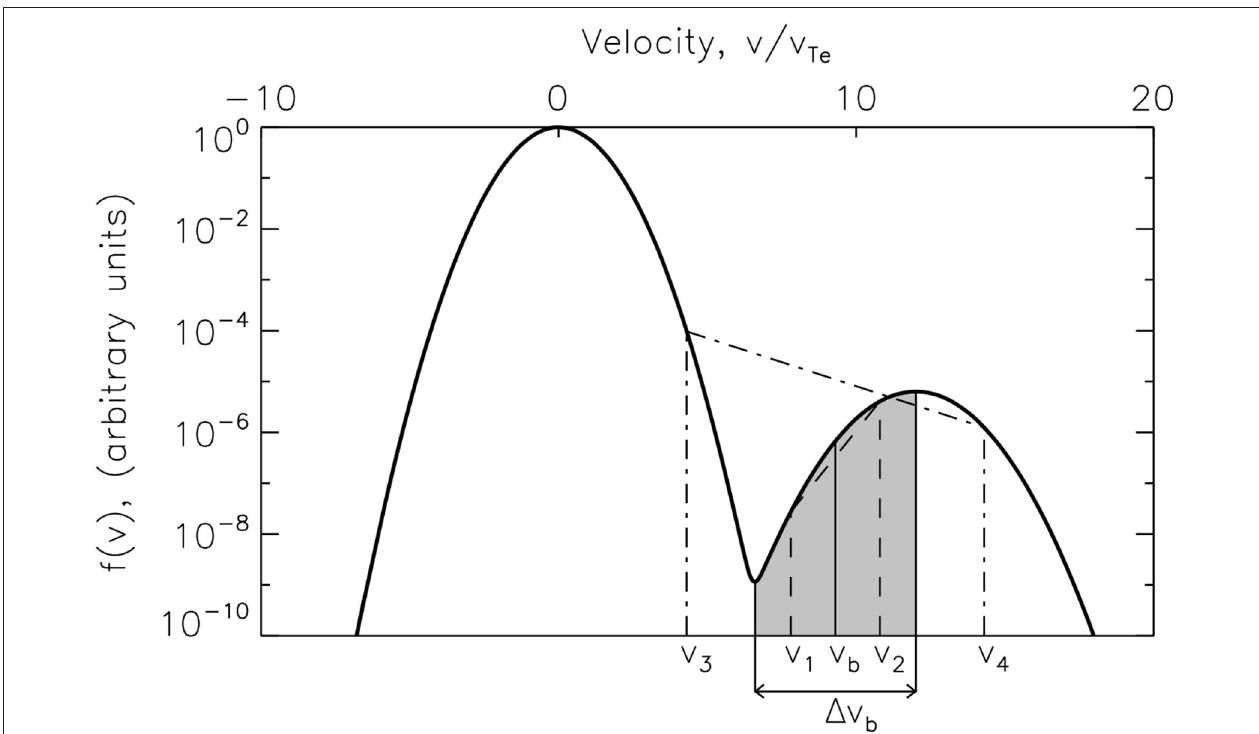
FIGURE 10 | An example of weakening and possible suppression of the beam instability by resonance broadening. The shaded gray corresponds to a positive slope from resonance width 1 v = v 2 − v 1. If the resonance width is increased to 1 v = v 4 − v 3 the slope becomes negative and the Langmuir wave instability is suppressed From Bian et al.